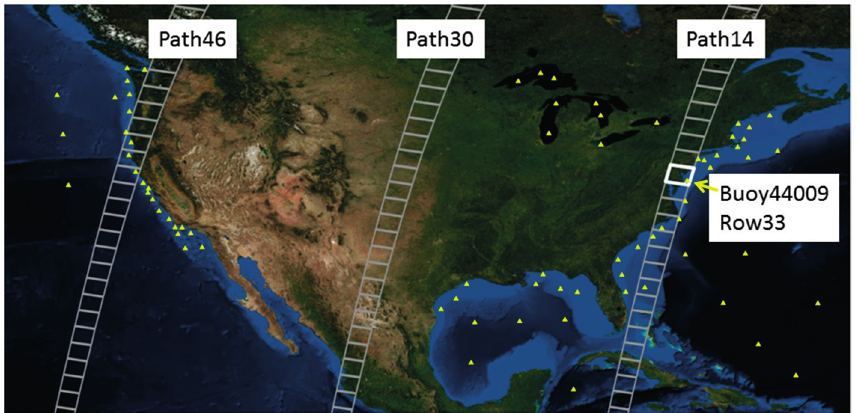
Figure 3. Example of possible Landsat 8 paths, buoys, and specific scene rows for 19 July 2013; triangles indicate buoy location.